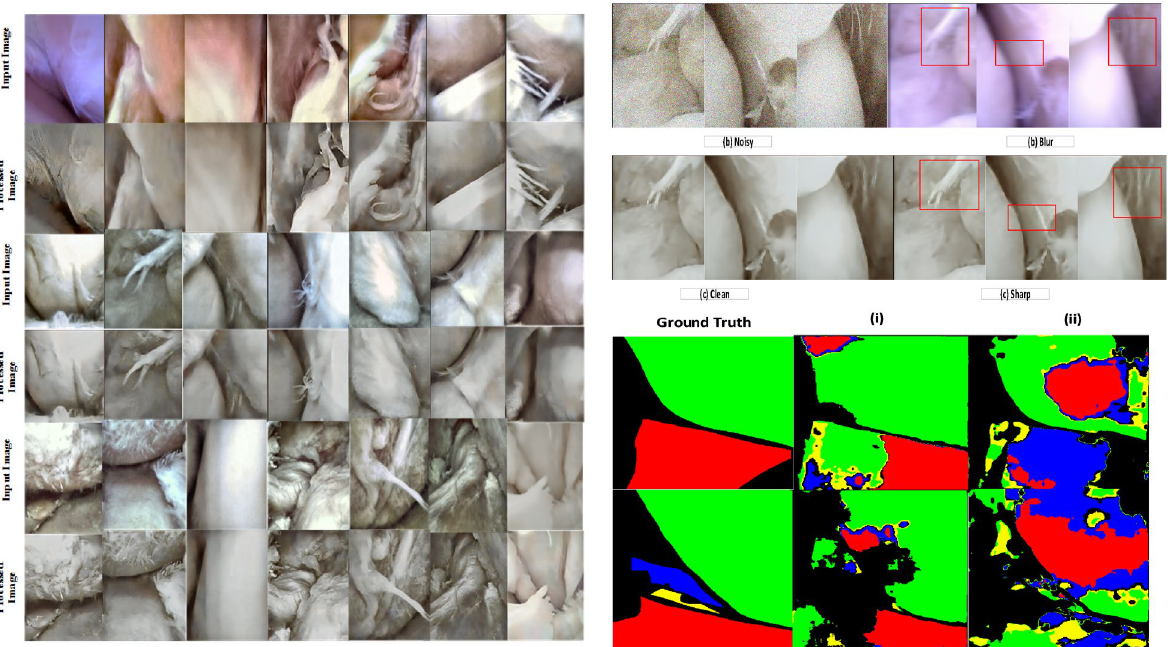
Figure 3. Images in the left column represents the visual representation of the real scene and the result obtained from our method. Here, the top row represents a real arthroscopic scene, and the subsequent rows represent the results. Images presented in the top right column show the outcome of IR tasks considering high-level noisy and blur data. Images at the bottom right compare ground truth segmentation with the output from or methods on arthroscopic scene segmentation. The first column represents the ground-truth label, column (i) represents segmentation results obtained from the preprocessed dataset using our method, and column (ii) represents results obtained from the same dataset without preprocessing. It is clearly showing that this framework increases the accuracy of the segmentation